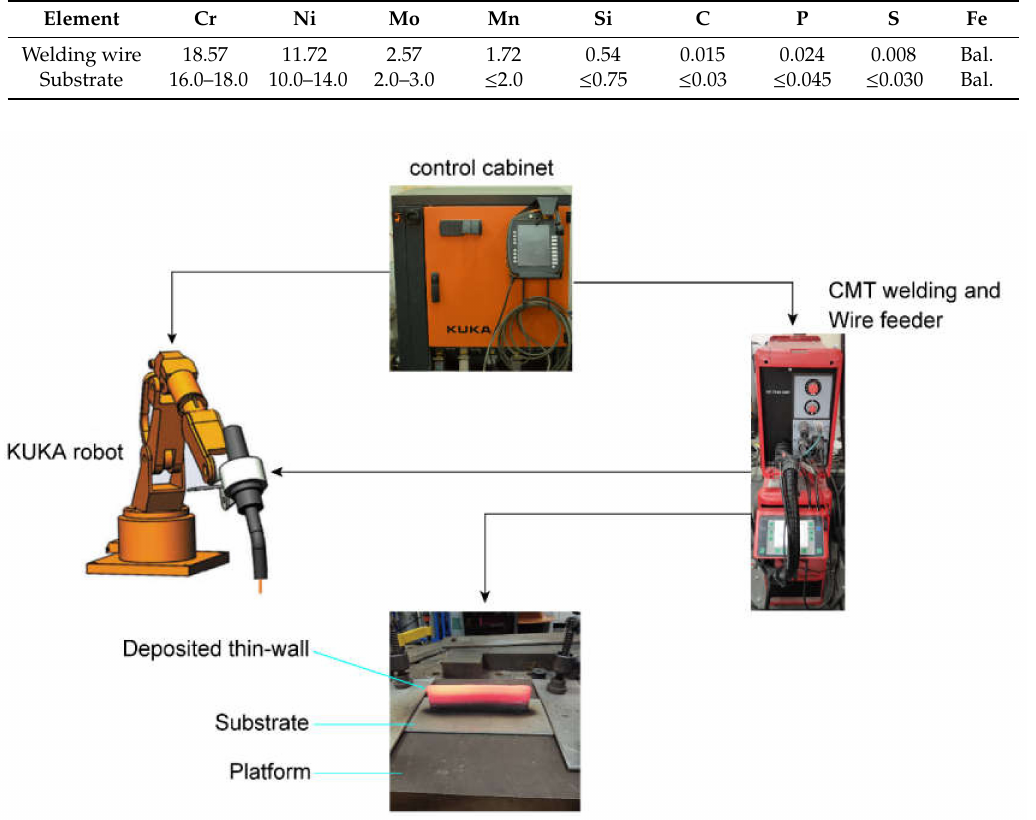
Figure 1. Cold metal transfer plus pulse (CMT + P) process additive manufacturing